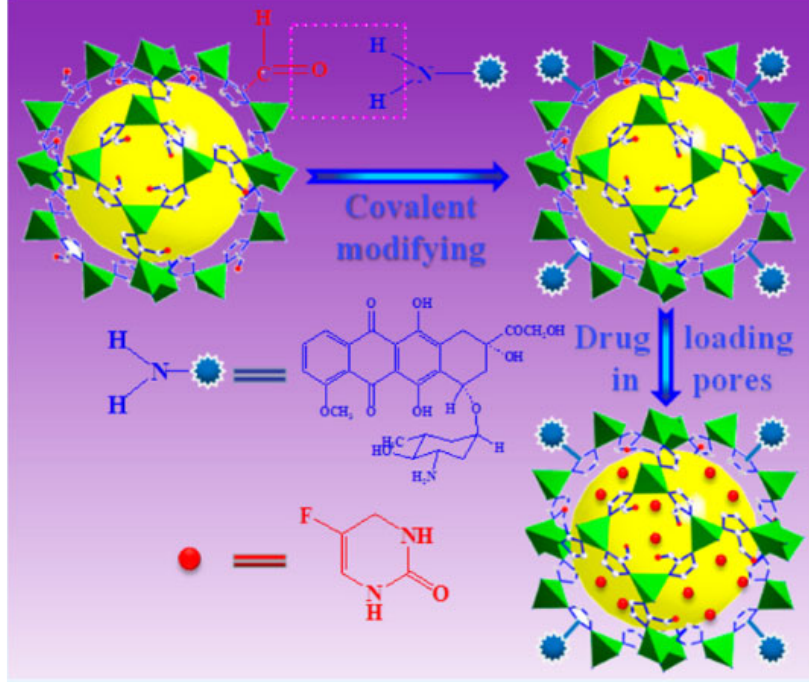
Figure 3. Two mechanisms through which drugs can be loaded into MOFs are shown. Covalently bonded doxorubicin (Blue), and non-covalently loaded 5-floururacil (red) inside MOF pores of ZIF-90. Reproduced with permission from [53].